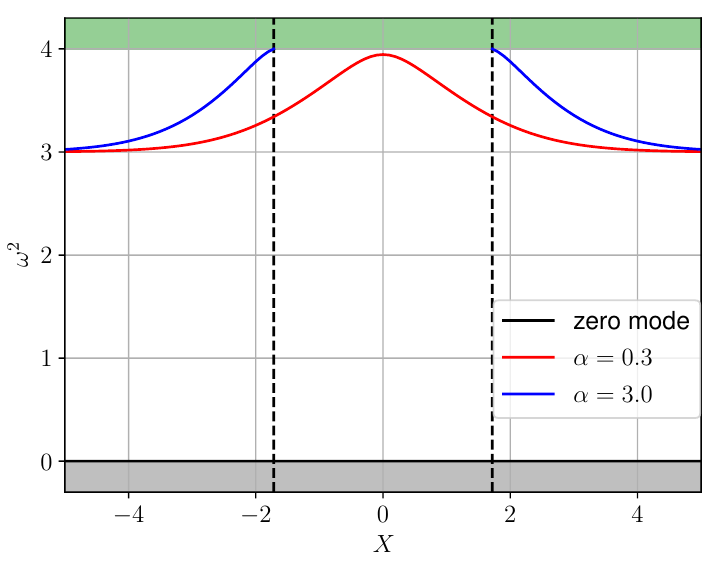
Figure 2 . Kink’s bosonic and fermionic spectrum as a function of X